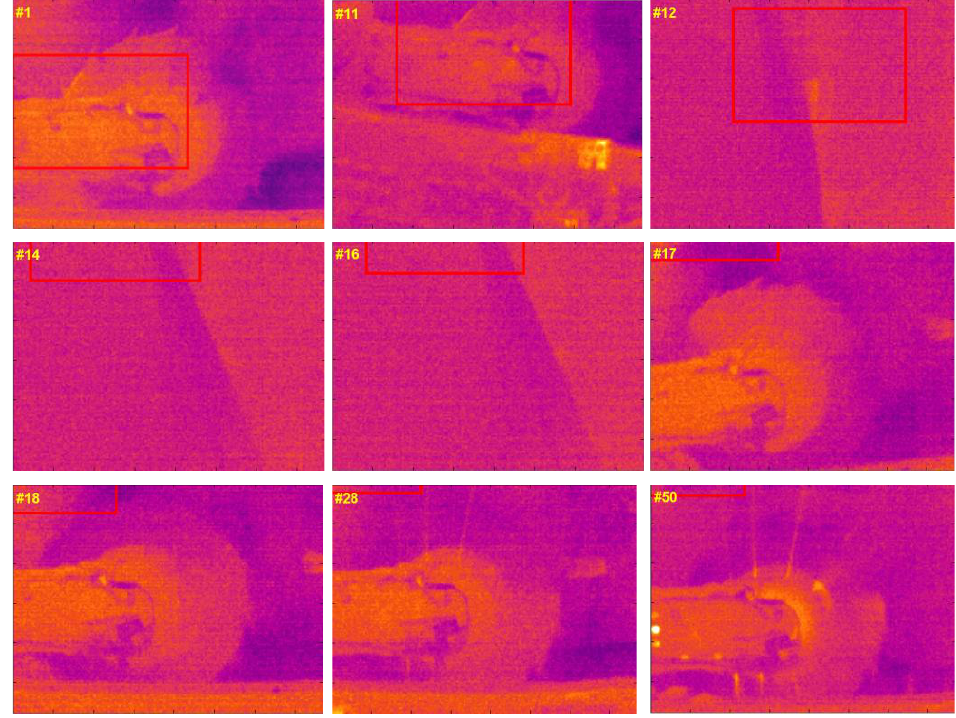
Figure 15. Tracking results of the cutting unit based on the single STC algorithm.